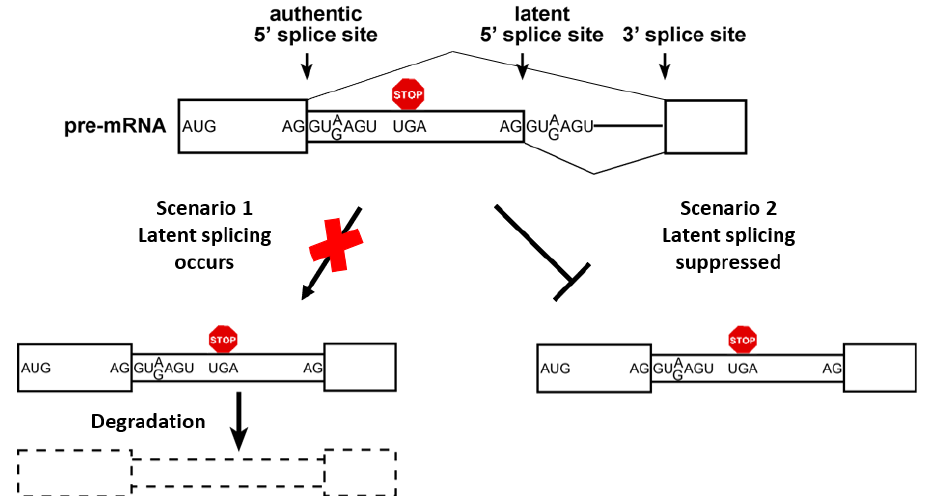
Figure 1. Suppression of splicing (SOS). Two scenarios for lack of latent splicing under normal growth conditions: scheme depicting the two scenarios that can account for lack of latent splicing under normal growth conditions, despite the abundance of LSS sequences in introns. As discussed, our studies have ruled out the first scenario [35,36,39,40]. Boxes, exons; narrow boxes, latent exons; lines, introns; red octagon, stop codon. Adapted from ref. [12].